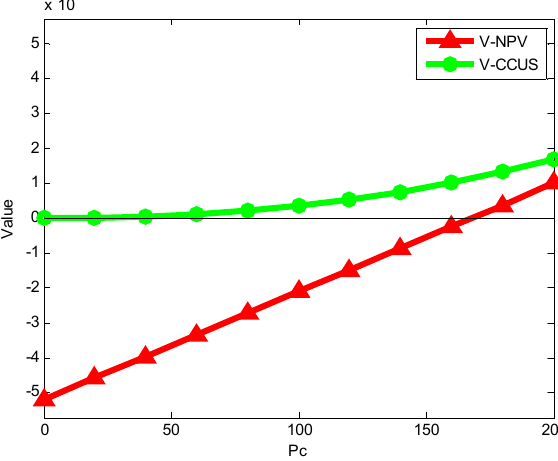
Figure 4. The impact of the carbon price on the investment value of CCUS without carbon